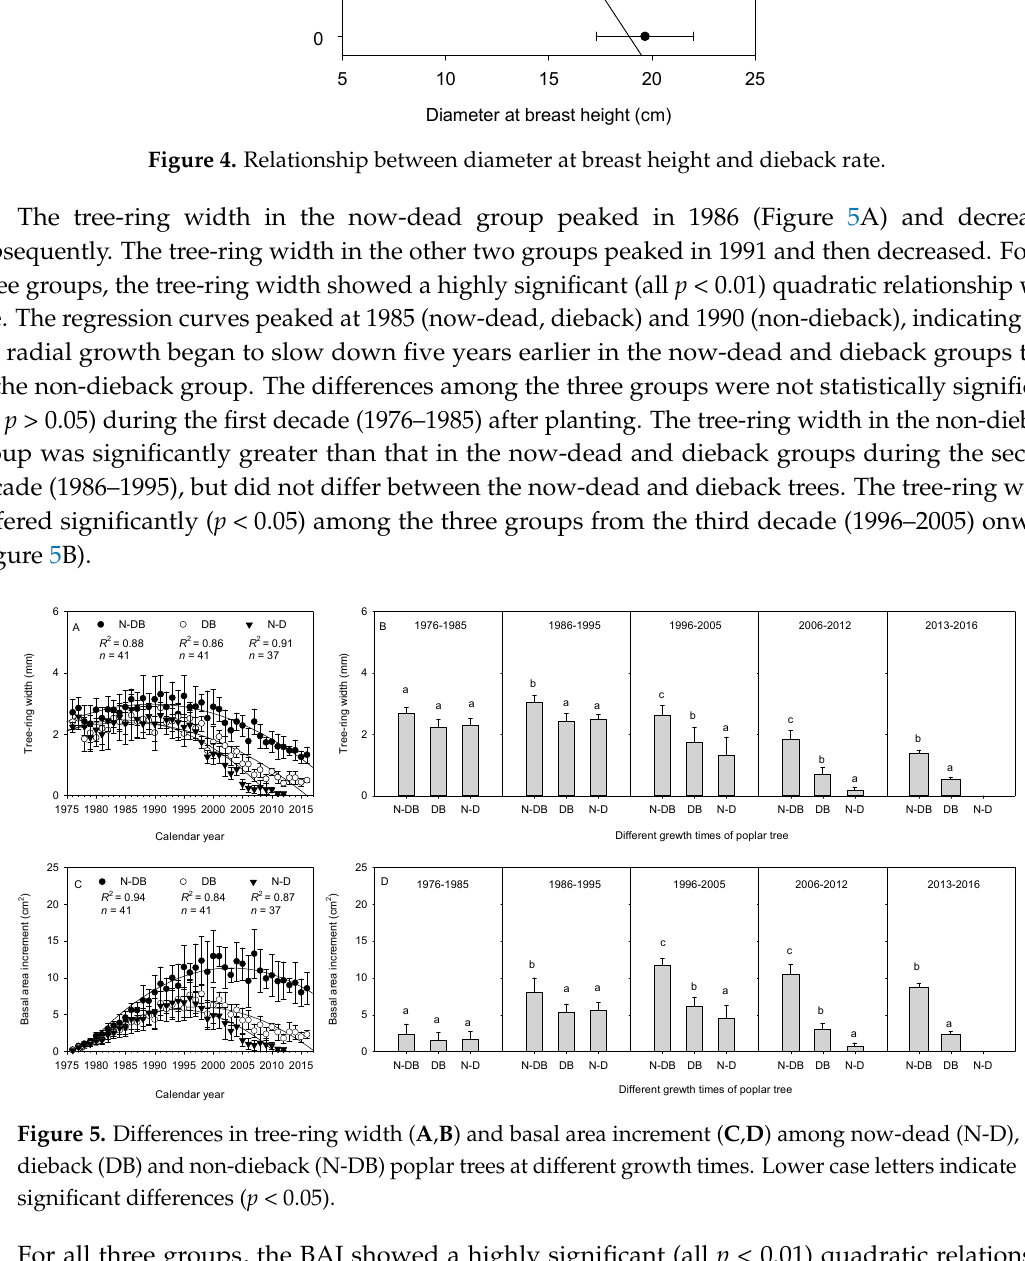
Figure 4. Relationship between diameter at breast height and dieback rate.